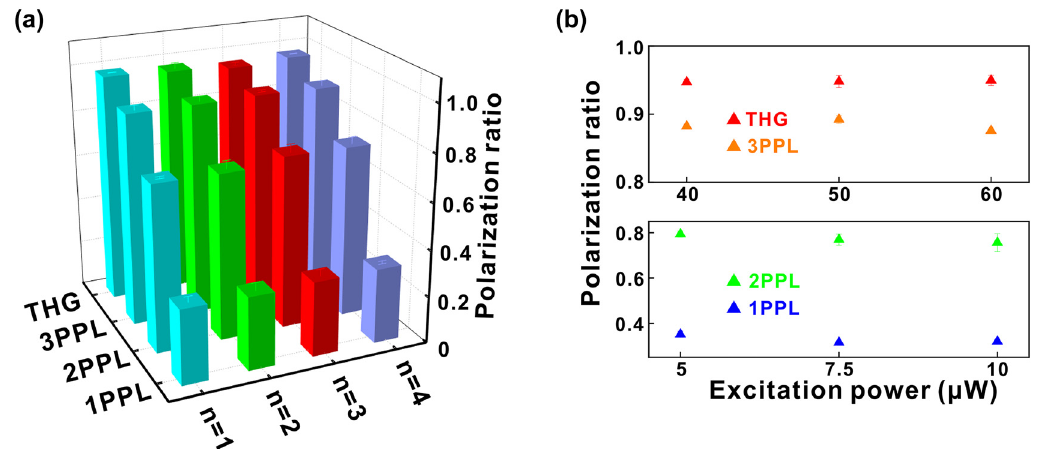
Figure 4: Comparison of polarization ratios of 2D RPPs linear polarization dependence for different optical processes. (a) Polarization ratios of 1PPL/2PPL/3PPL and THG for 2D RPPs linear polarization dependence. The excitation powers are 10 μ W for the 1PPL and2PPLprocesses,andare27 μ Wforthe3PPLandTHGprocesses.Theexcitationwavelengthsare400,800,1500,and1800nmforthe1PPL, 2PPL 3PPL, and THG processes, respectively. (b) Polarization ratios of 1PPL/2PPL/3PPL and THG for 2D RPPs ( n = 2) linear polarization dependence under different excitation